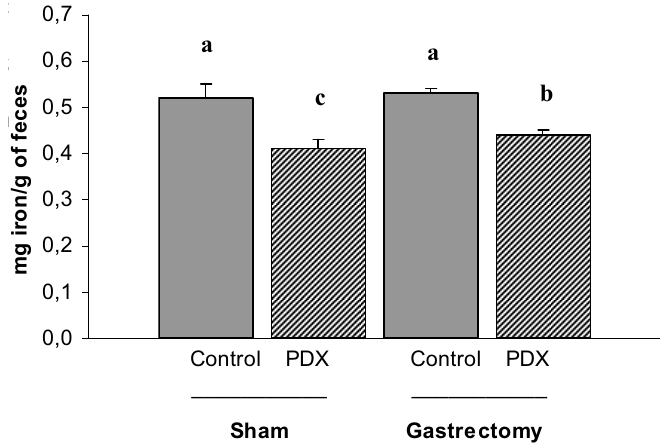
FIGURE 4 - Fecal iron concentration (mg/g feces) in sham operated or with gastrectomy rats fed diets with (PDX) or without (control) polydextrose. Each values represents the means ± SEM (Sham/Control: n= 10; Sham/PDX: n=10; Gastrectomy/Control: n=9; Gastrectomy/PDX: n=9). Two ANOVA main effects (treatment and diet) and interactions (treatment x diet) were significant. Diet (control or PDX) treatment (with or without gastrectomy). Bars not sharing a common superscript are significantly different, p<0.05 (Duncan‘s multiple range test)